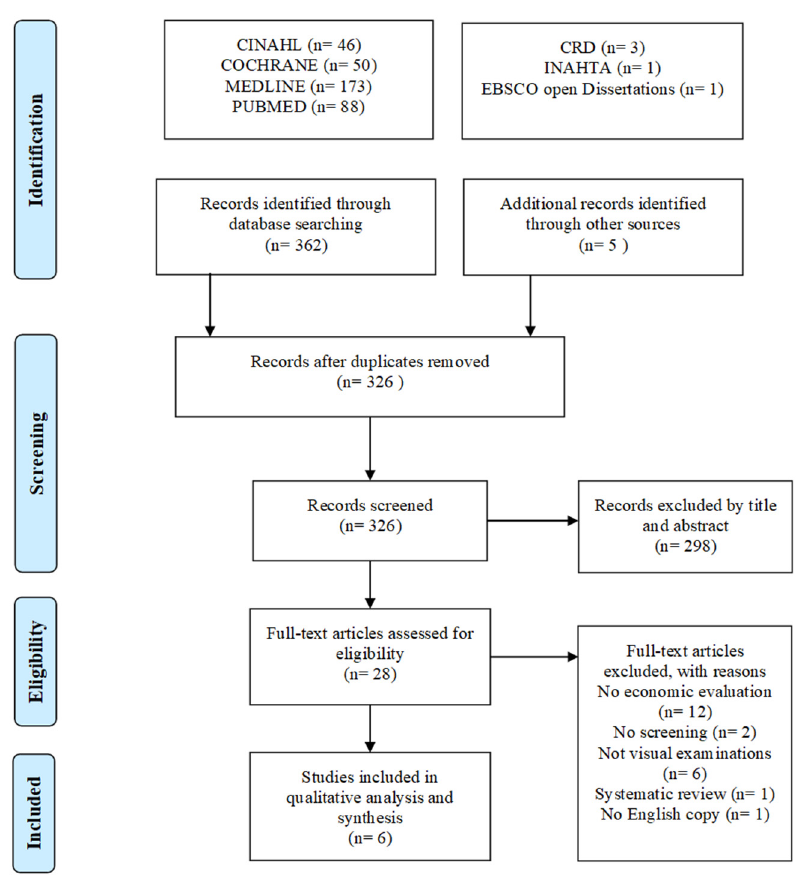
Figure 1. Flow chart of literature search.